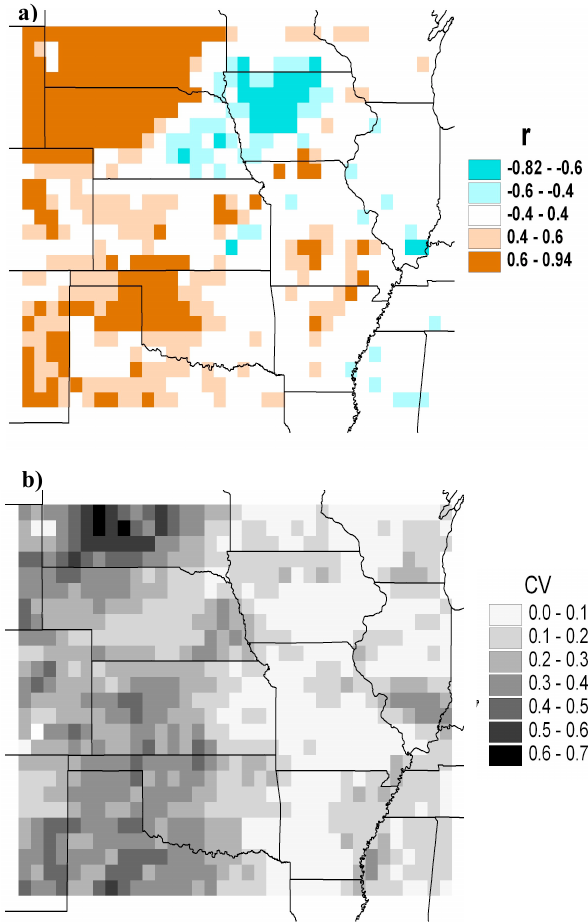
Fig. 4. Peak monthly average green LAI (July 1981–June 1991) and the month in which it occurs. From the AVHRR NDVI-based dataset of Buermann et al. (2002).